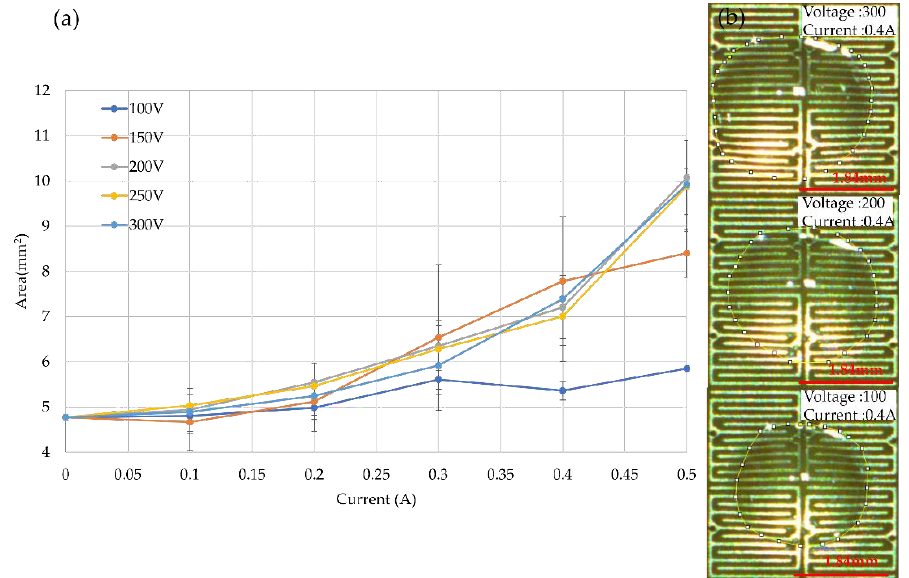
Figure 7. Droplet expanding experiment for voltage influence ( n = 5). ( a ) Droplet expanded area result with the voltage condition fixed. ( b ) Demonstrate the droplet expand situation when the voltage was from 100 V to 300 V at a current of 0.4 A.